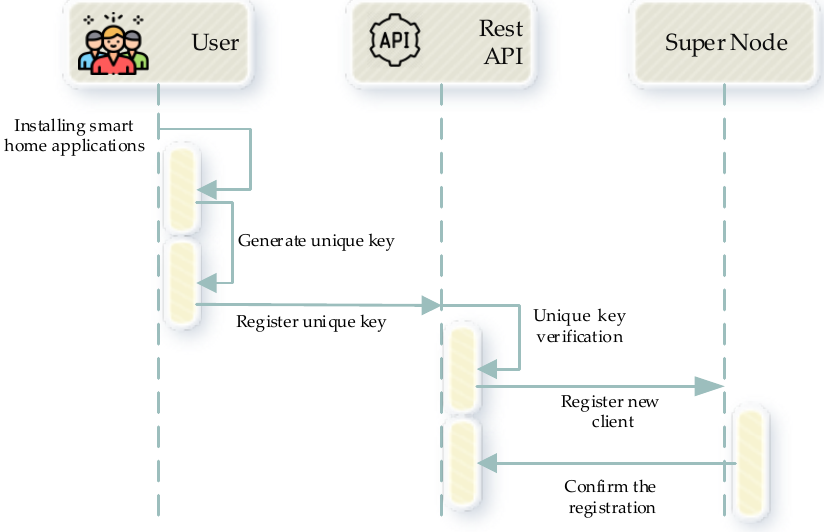
Figure 5. Process of user authorization.